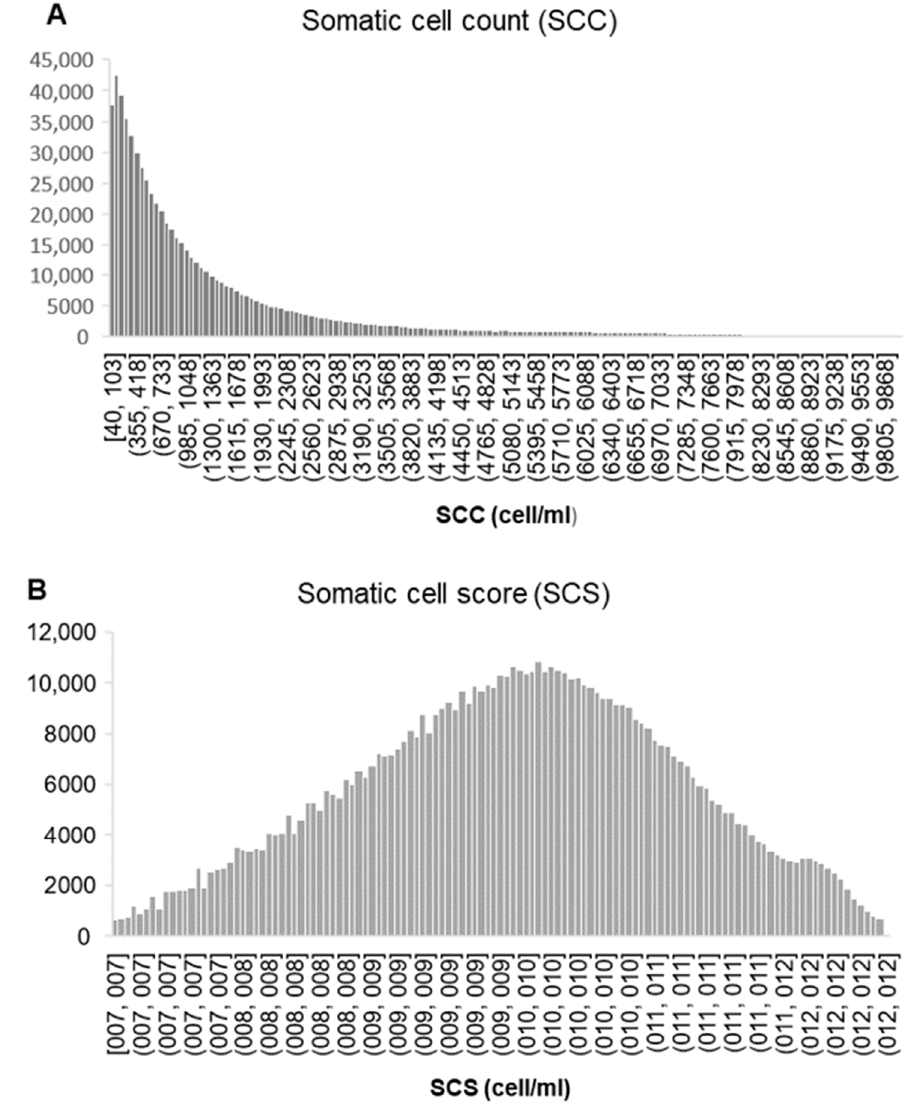
Figure 1. Frequency distribution of the variable somatic cell count (SCC) in Florida goat before ( A ), and after logarithmic transformation (SCS, ( B )).